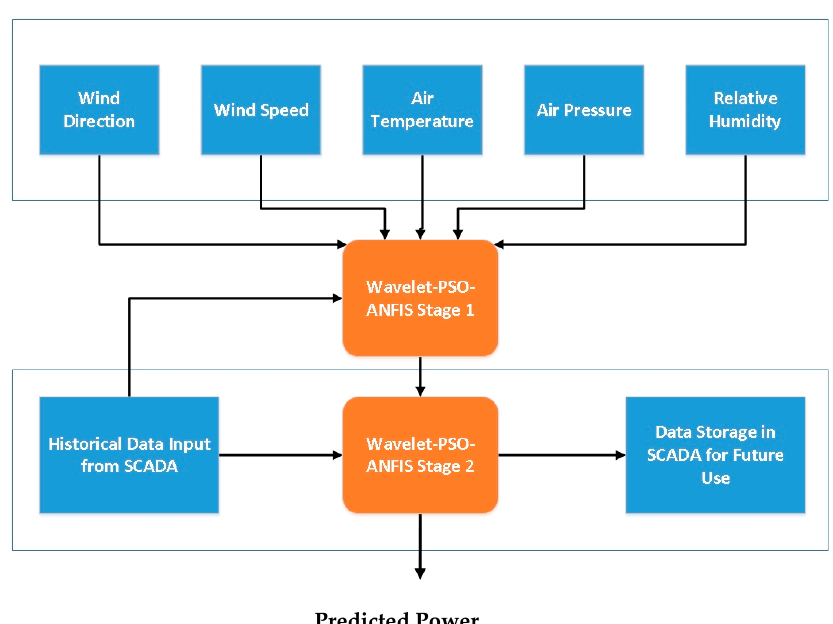
Figure 1. Proposed Double Staged Wavelet-PSO-ANFIS Forecasting Model.